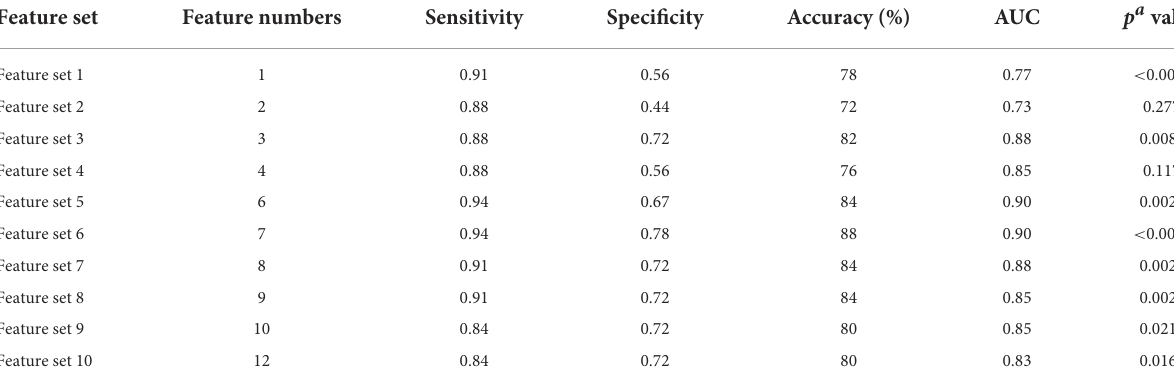
TABLE 3 Results for each classifier corresponding to feature selection.